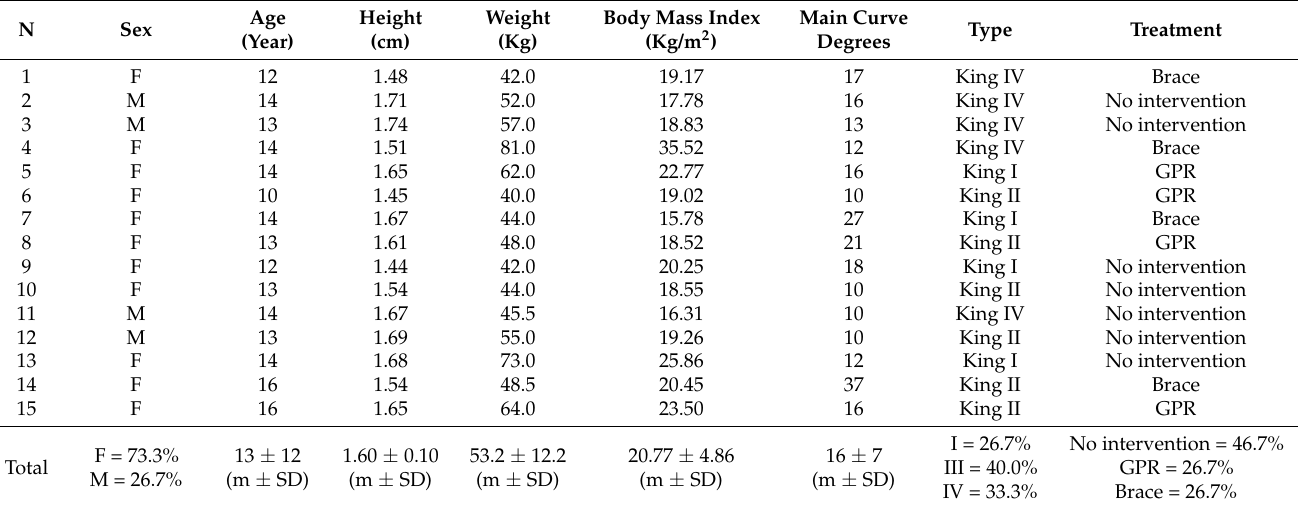
Table 1. Sociodemographic characteristics.